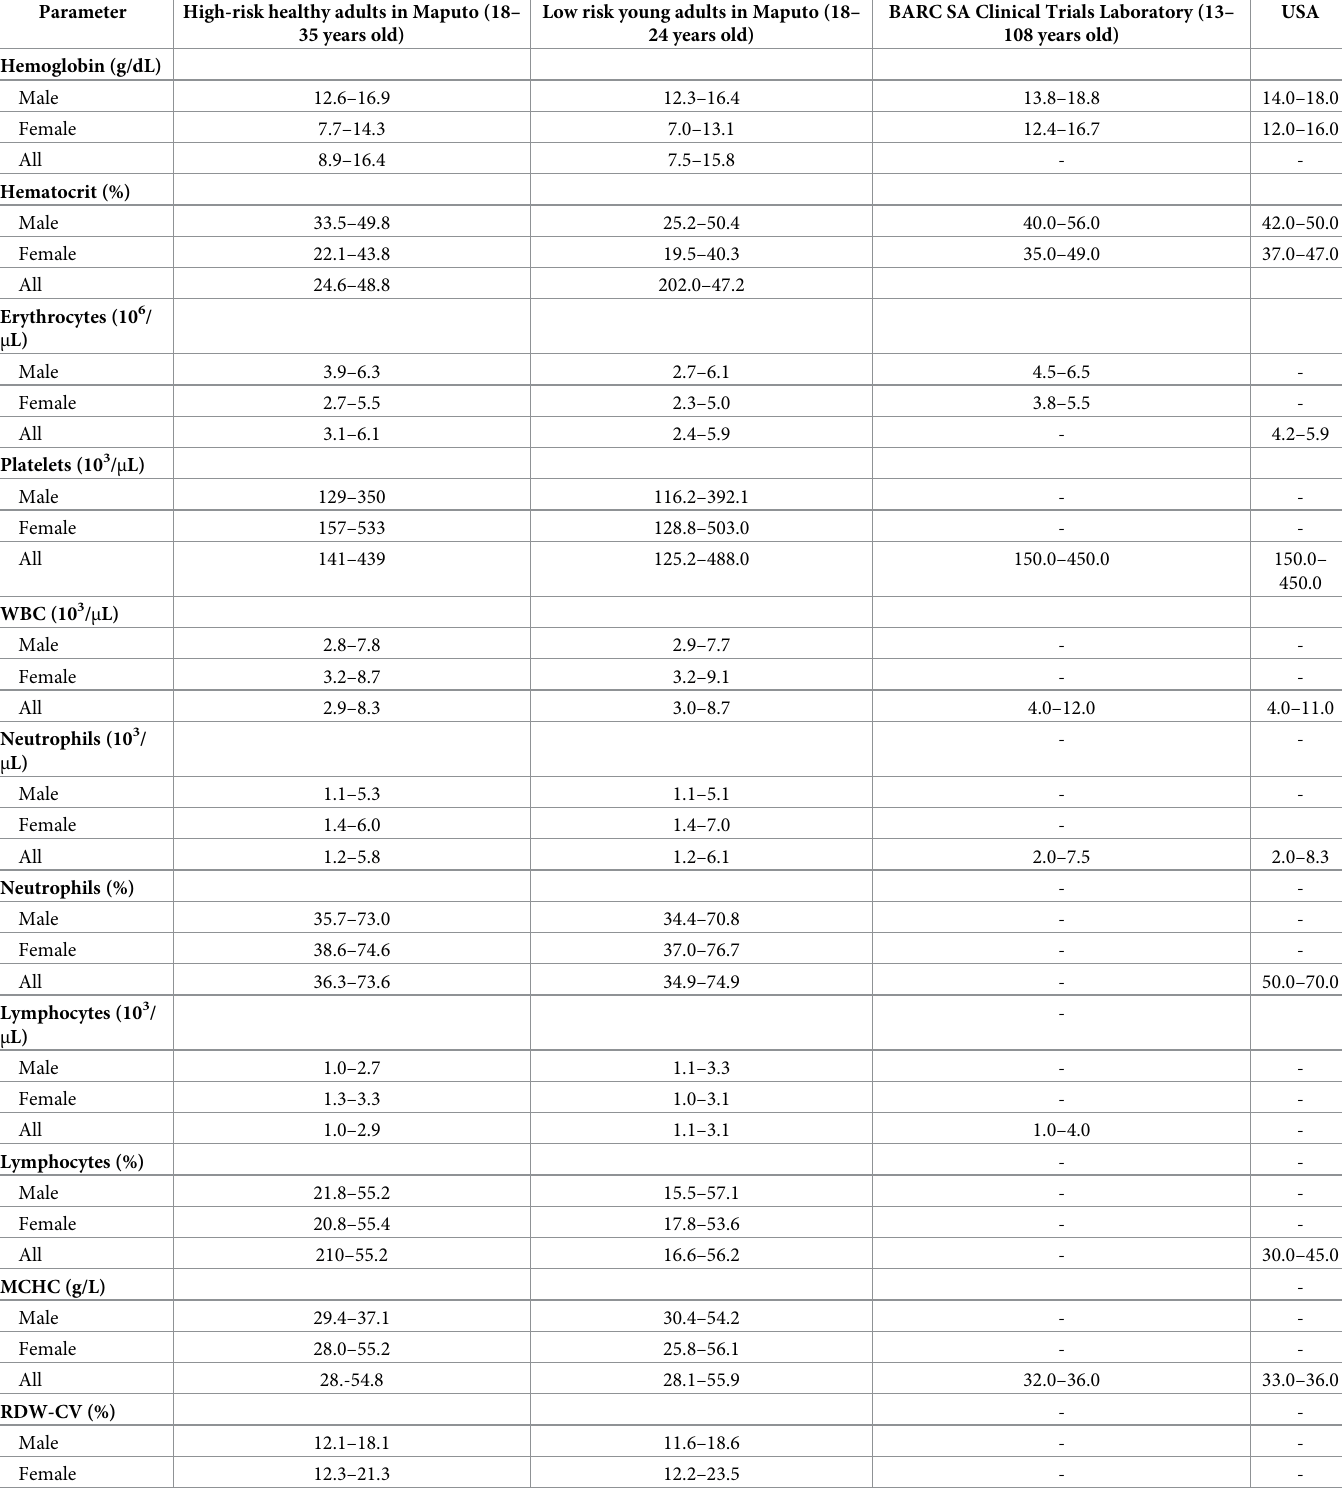
Table 2. Hematology reference ranges from healthy adults at high-risk for HIV in Mozambique compared with local (low risk healthy adults), regional (south africa) and international countries (USA).